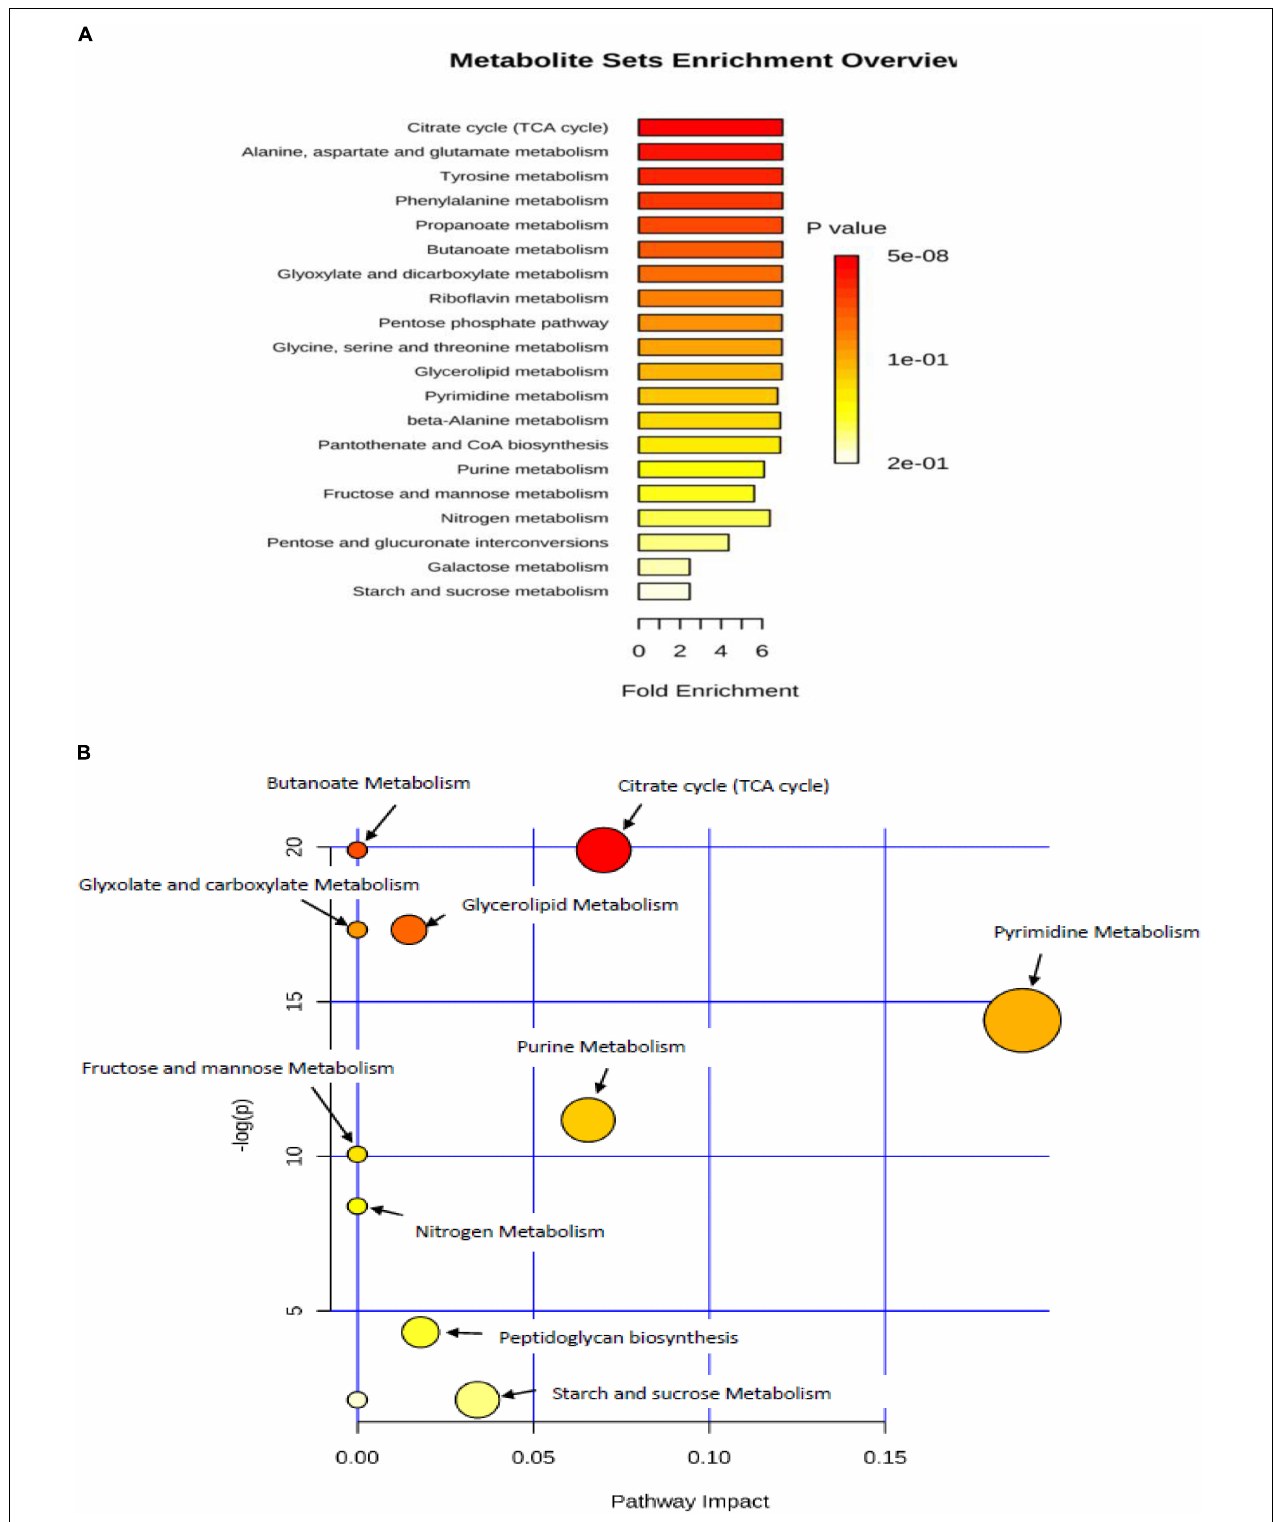
FIGURE 4 | (A) metabolic set enrichment using metabolite concentrations showing the most enriched pathways in response to lower temperature of 4 ◦ C. (B) Pathway impact analysis. All the matched pathways are shown as circles. The color and size of each circle is based on p -value and pathway impact value, respectively. Colors of the circle based on p -values. The darker colors indicate more significant pathway ( p < 0.05 ).